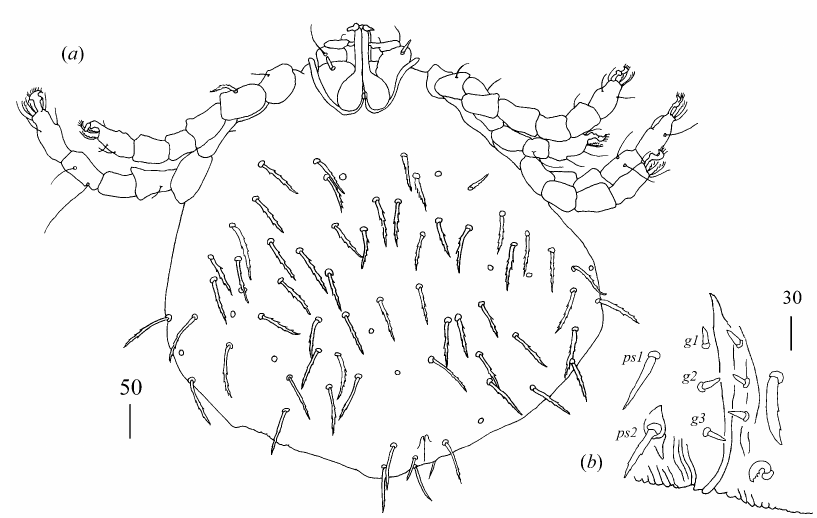
Figure 9. Geckobia mysoriensis sp. n.: ( a ) deutonymph in dorsal view; ( b ) genital region of larva.